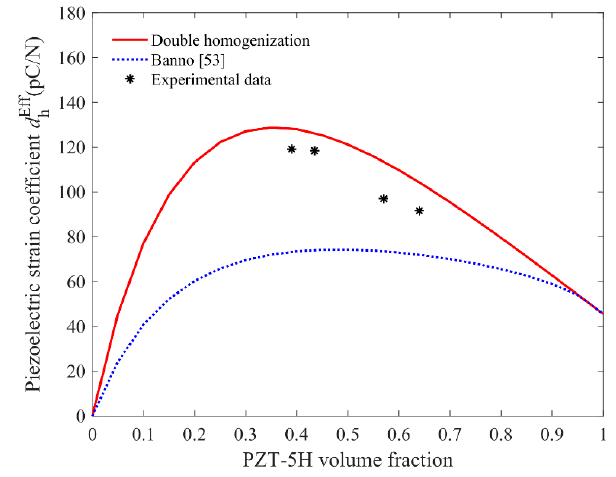
d . Figure 13. Comparison between the experimental and theoretical values of d Eff . Materials 2018 , 11 , x FOR PEER REVIEW 14 of 21 33 d . 33 33